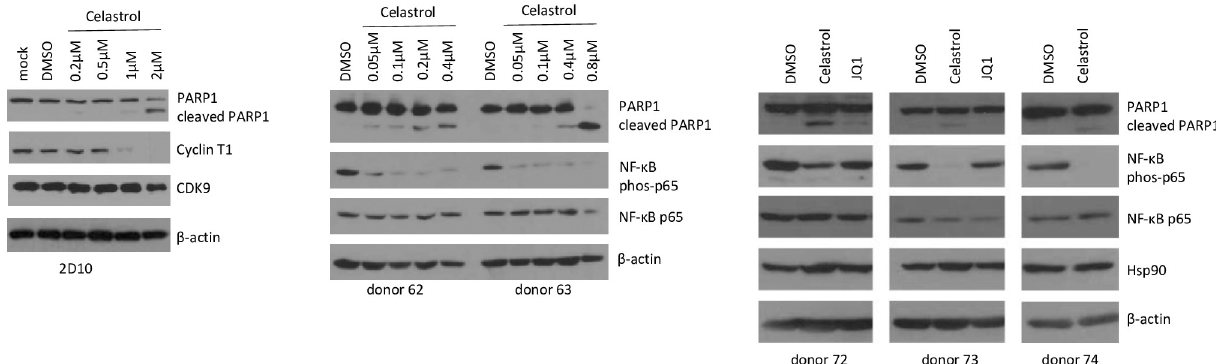
Fig 5. Induction of apoptosis and inhibition of NF- κ B by celastrol. A. Jurkat 2D10 cells were treated with DMSO or the indicated concentration of celastrol; mock-treated cells did not receive any treatment. Cell extracts were prepared at 24 hours post-treatment and the indicated proteins were analyzed in an immunoblot. B. Resting CD4 + T cells from two healthy donors were treated with DMSO or the indicated concentration of celastrol. Cell extracts were prepared at 24 hours post-treatment and the indicated proteins were examined in immunoblots. C. Resting CD4 + T cells from three healthy donors were treated with DMSO, 400 nm celastrol or 200 nM JQ1. Cell extracts were prepared at 24 hours post-treatment and the indicated proteins were examined in